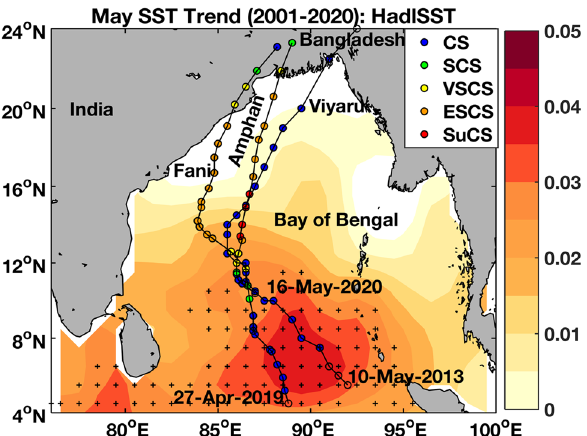
Figure 2. The background is the warming trend ( ◦ C /year in colorbar) of SST during May. Note that all three recent cyclones utilized the warming in the southeastern Bay of Bengal to intensify, although Viyaru was limited in intensity by its more eastward track. The shaded ‘+’ regions show 95% significance of the SST trend. The map (coastlines) is created with Matlab M_Map v1.4 toolbox (https:// www. eoas. ubc. ca/ ~rich/ map.